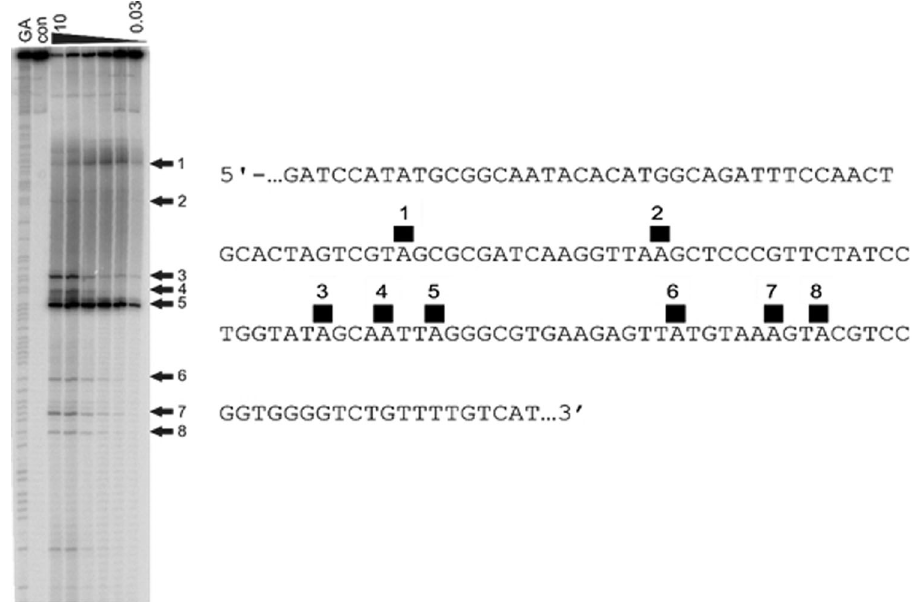
Fig. 4 DNA cleavage assay for the G-A cross-linking agent FGX8-46 (6) on DNA fragment MS1. The MS1 was incubated with 10, 3, 1, 0.3, 0.1 and 0.03 μ M of 6 (indicated at top of gel) in 10 mM Tris-HCl, 10 mM NaCl at pH 7.5 overnight at 37 °C, and a dose-dependent effect is evident ( Left ). The ’ GA ‘ lane contains Maxam-Gilbert markers speci fi c for purines, and the ‘ con ’ lane is a control in the absence of 6 . The arrows show the locations of cleavage sites due to the CBI component of 6 , thus indicating covalent A-binding positions. The sequence of the labelled DNA strand is provided ( Right ), with the cleavage sites numbered to correspond to the arrows on the gel.